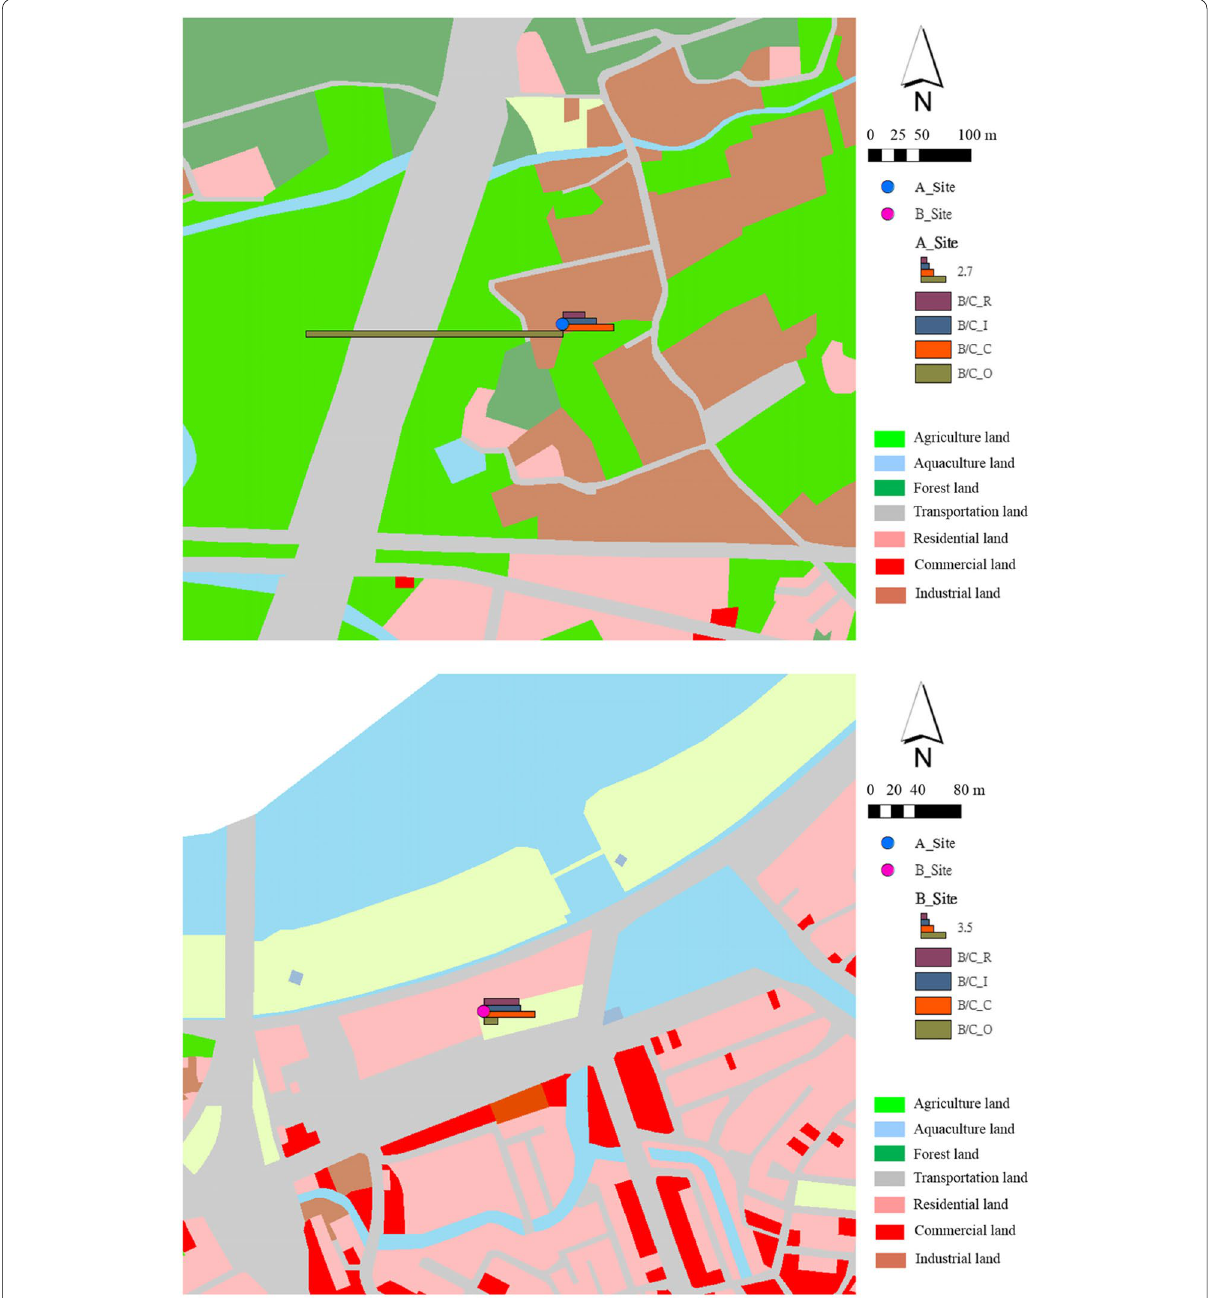
Fig. 9 The land use types and consolidation benefit‑cost ratios of two